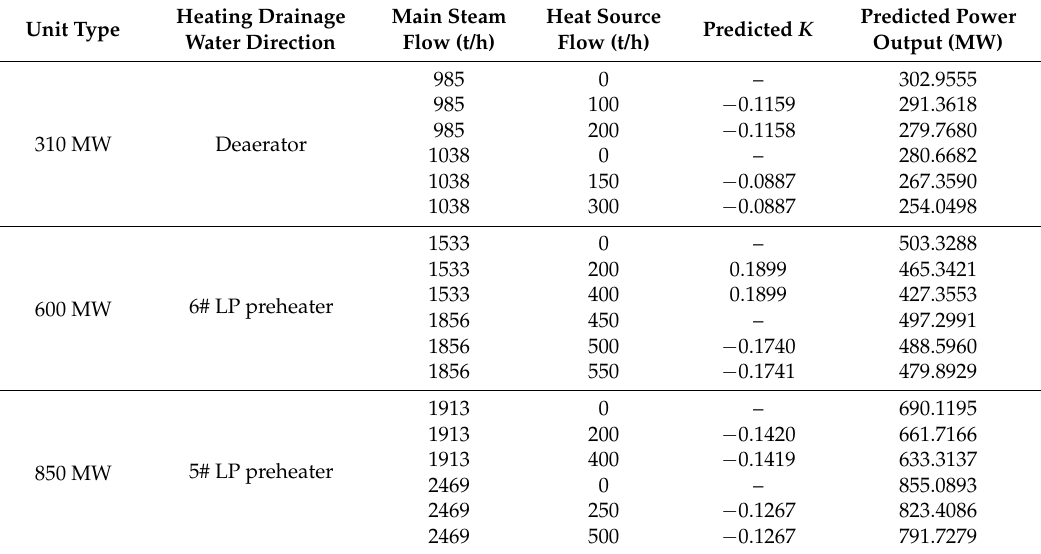
Table 2. Predicted K for some typical